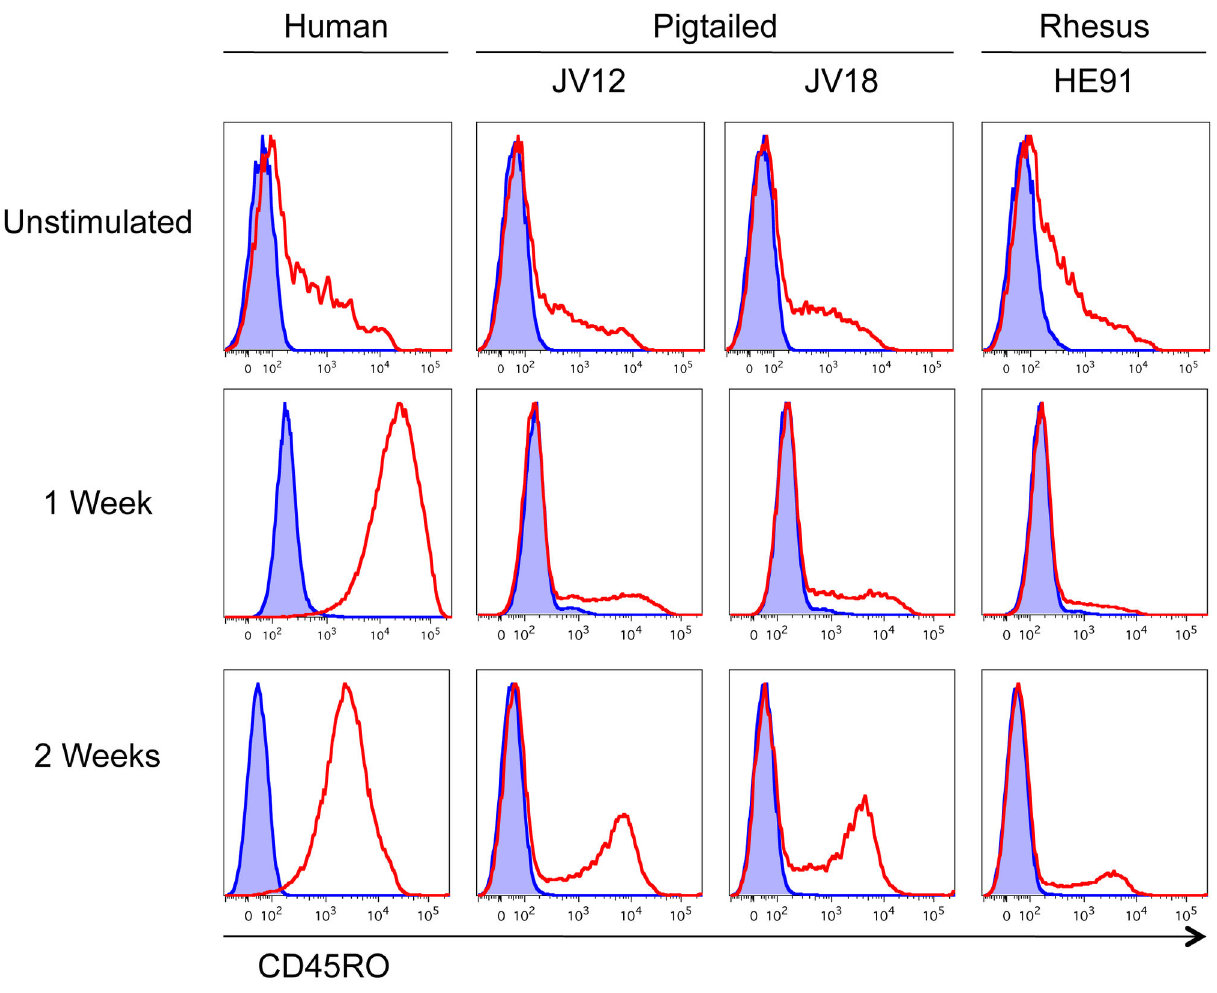
Figure 9. Mitogen stimulation and CD45RO expression. Cryopreserved PBMC from human, and uninfected pigtailed (JV12 and JV18) and rhesus (HE91) macaques were stained with UCHL1-multimers or were stimulated with PHA for 48 hours, and then maintained in medium containing IL-2. The resulting blast cells were stained with UCHL1-multimers on days 7 and 14. Cells were analyzed by flow cytometry. Acquired cells were gated on singlets and lymphocytes by light scatter. UCHL1-multimer staining is shown in red. Isotype controls (biotinylated IgG2a-streptavidin-PE multimers) are shown in